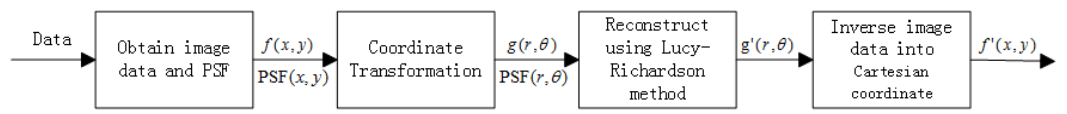
Figure 5. Flow chart of log-polar transformation and L-R algorithm super resolution.